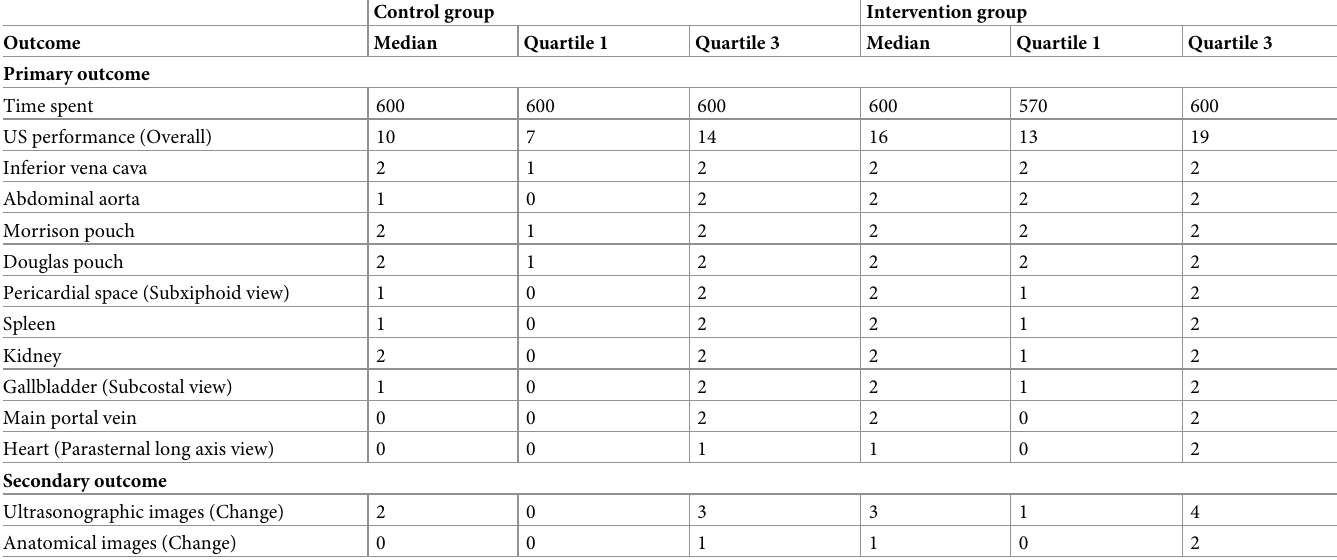
Table 3. Descriptive statistics of ultrasonographic task performance and the change of written tests score in each